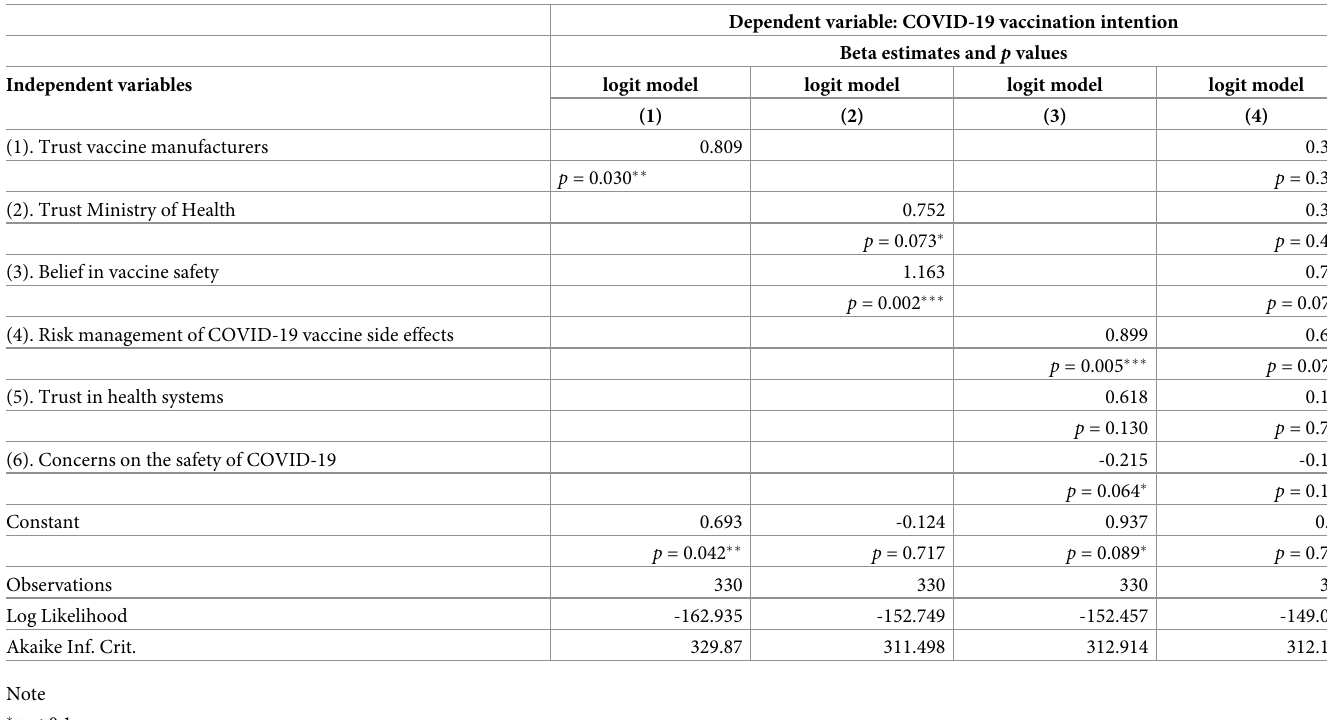
Table 3. Attitude on COVID-19 vaccination intention (hierarchical binary logistic